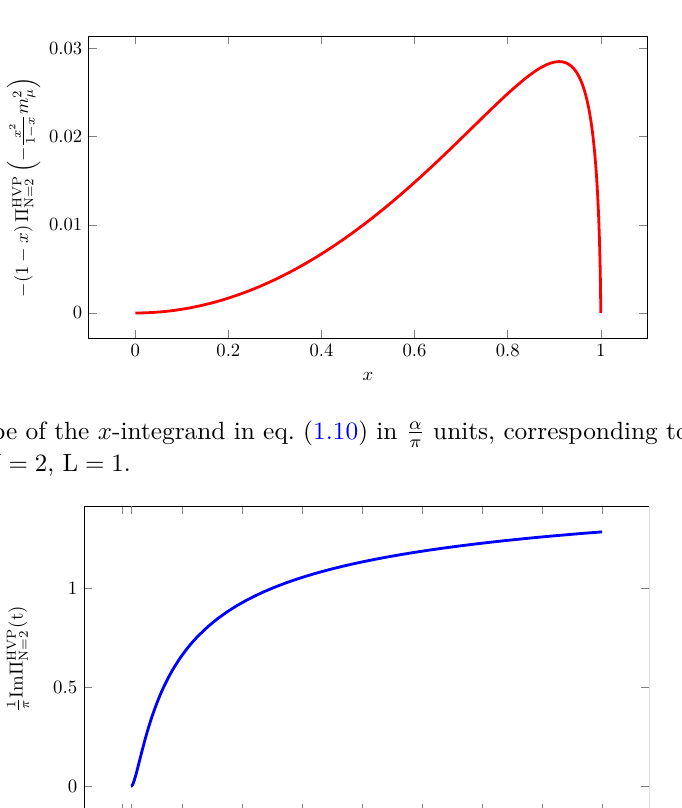
Figure 3 . Shape of the spectral function for N = 2 in α